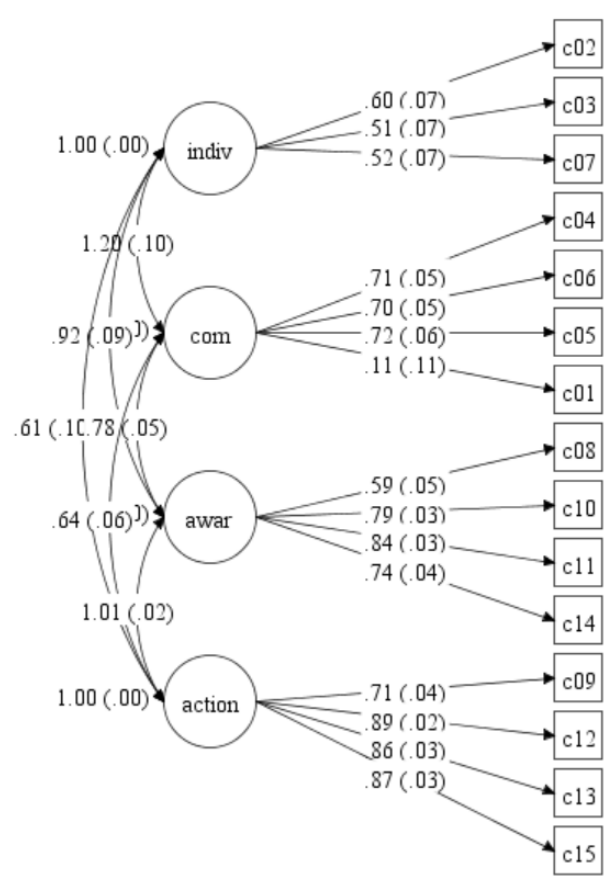
Figure 1. Confirmatory factor analysis with structural equation model. From left to right, the item number (inside the box), loadings of the items of the questionnaire (in the center of the arrows), and covariation among the latent constructs (the arrows connecting the spheres) are shown for the four-factor model. Comparative fit index = 0.90; root mean square error of approximation = 0.16; chi-square = 373.227; degrees of freedom = 84. Note: indiv = individual self-efficacy; com = community self-efficacy; awar = community intervention awareness; action = community intervention actions.